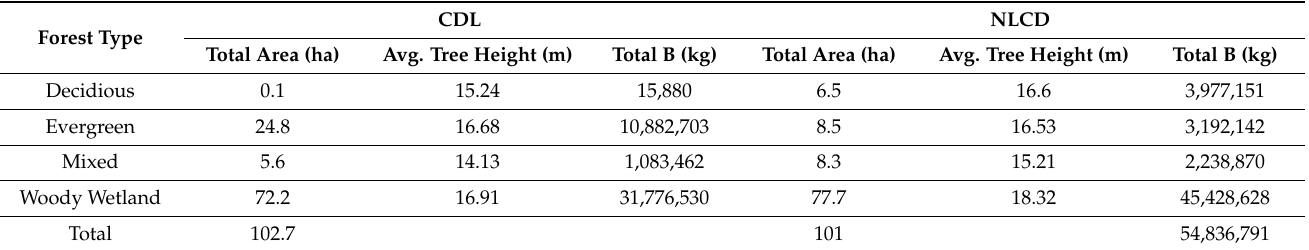
Figure 6. Study area: Spatial distribution of AGFB based on CDL ( left panel ) and NLCD ( right panel ). We calculate the region-total AGFB as a sum of the AGFB of all of the individual trees in the region (Table 7). The main inputs of the biomass calculation, forest areas, and tree heights, are reported to facilitate the comparison and discussion of the results. Table 7. Study-region total AGFB